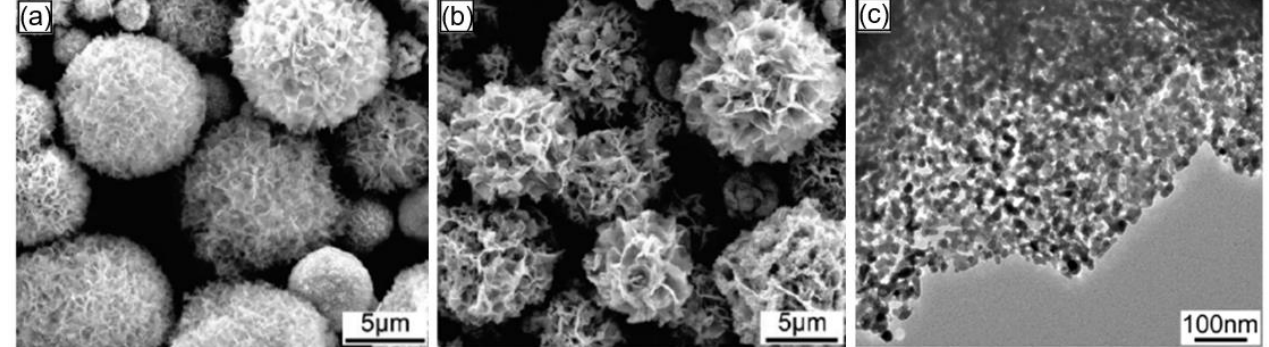
Figure 22. ( a ) FESEM image of the as-synthesized In 2 S 3 precursors, ( b ) FESEM image of the products (In 2 O 3 ) obtained by oxidizing In 2 S 3 precursors. ( c ) HRTEM images of In 2 O 3 nanoflakes. Reprinted with permission from Liu et al. [150]. Copyright 2010: ACS.